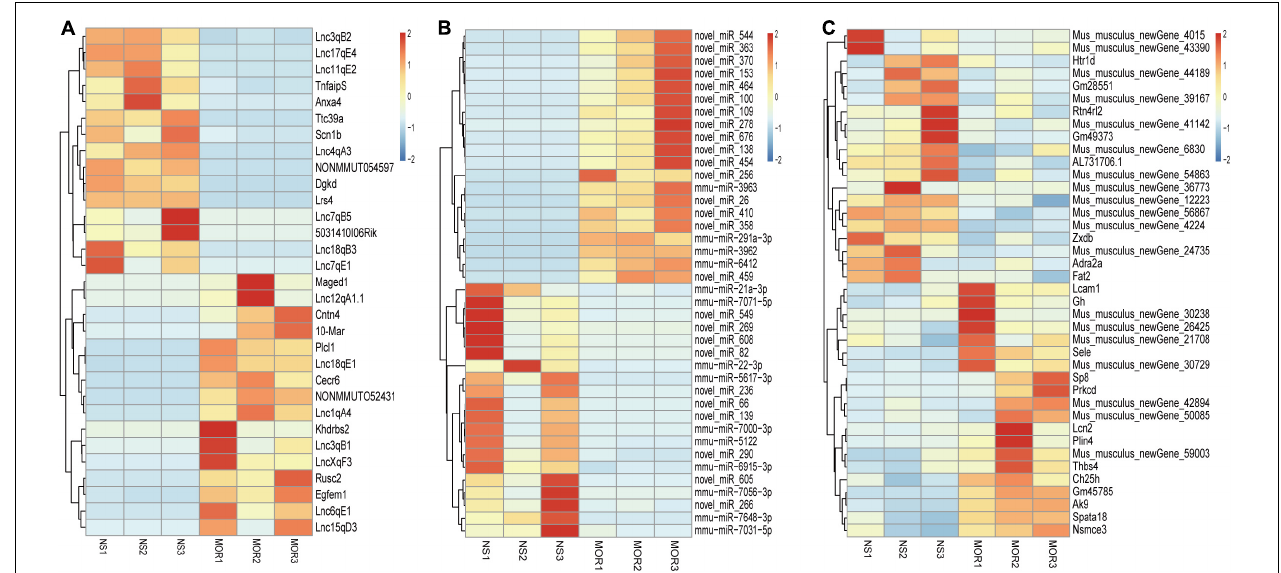
FIGURE 2 | Heatmaps of differentially expressed lncRNA (A) , miRNA (B) , and mRNA (C) profiles. Unsupervised clustering analysis show the expression profiles of differentially expressed lncRNAs, miRNAs (top 40), and mRNAs (top 40) in the morphine group compared to saline group. MOR1, MOR2, and MOR3 represent the NAc tissue of three mice treated with morphine. NS1, NS2, and NS3 represent the NAc tissue of three mice treated with saline. Red indicates upregulation, and blue indicates downregulation.